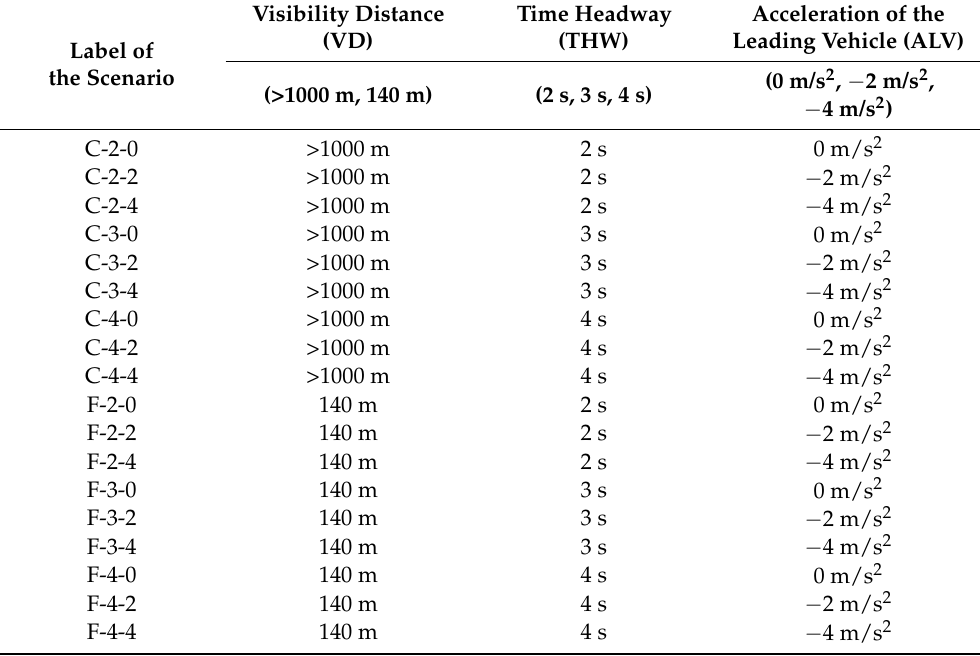
Figure 3. The visibility scene used in this study: ( a ) clear weather with visibility >1000 m and ( b ) fog condition with the visibility of 140 m. Table 1. Labels and three independent factors of 18 driving